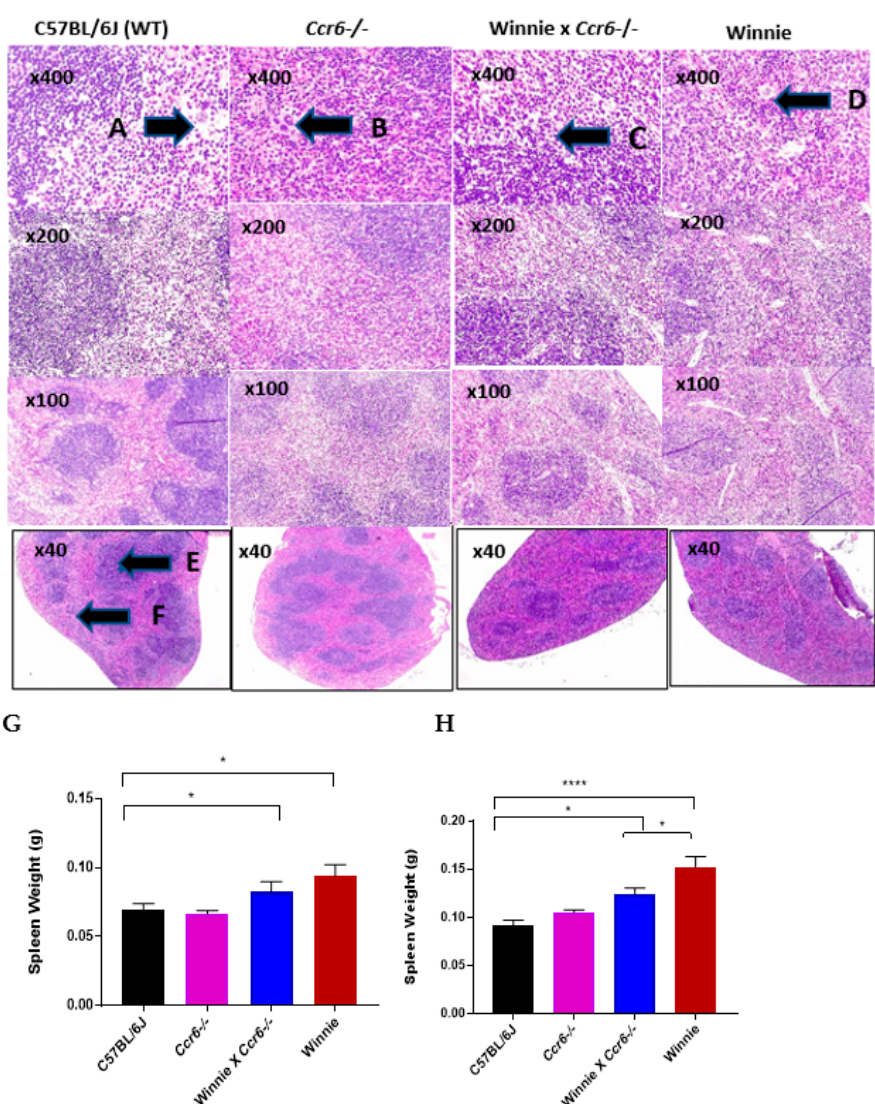
Figure 4. Representative images of H&E in spleen histology in the four genotypes at 16–22 weeks of age. Arrows indicate ( A ) megakaryocyte in WT, ( B ) neutrophil reaction in Ccr6 − / − , ( C ) neutrophil reaction in Winnie × Ccr6 − / − , ( D ) neutrophil reaction in Winnie, ( E ) red pulp, ( F ) white pulp, ( G ) comparison of spleen weight in the four genotypes at 8 weeks of age and ( H ) comparison of spleen weight in the four genotypes at 16–22 weeks of age. Data expressed as Mean ±SEM by one-way analysis of variance (ANOVA) and Tukey’s multiple comparison test, n = 7, p ≤ 0.0001 (****). Inflammation was quantified in the genotypes by counting the numbers of neutrophils in three consecutive similar areas on the slides and comparing the mean value using a scoring index from 0–3, from no inflammation to severe neutrophil infiltration, where